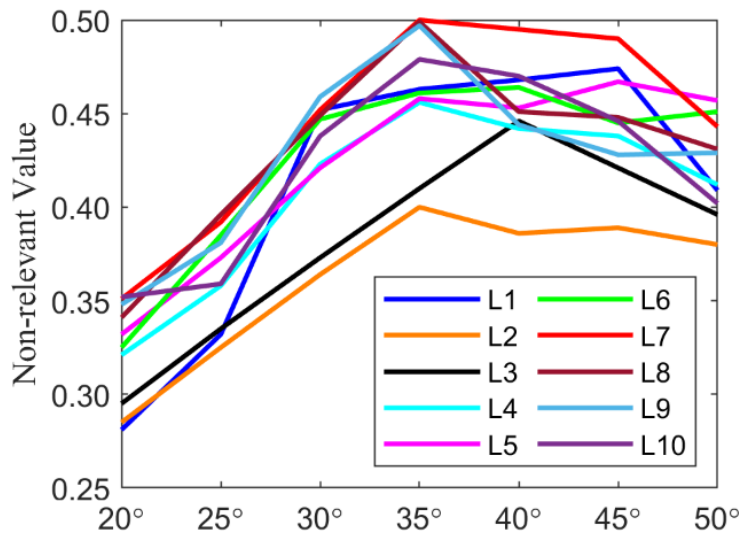
Figure 10. Relationship between NR and internal parameters.